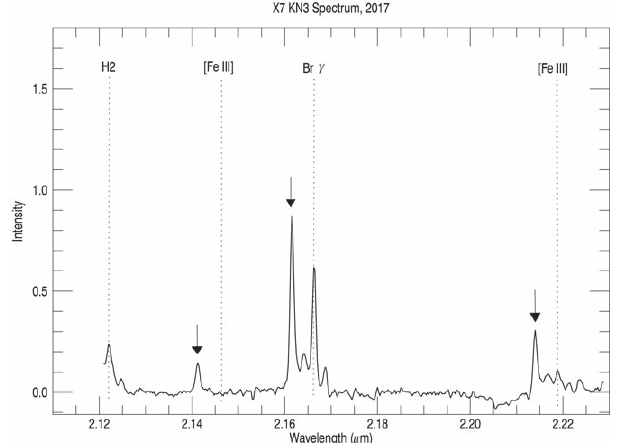
Figure 3. Spectrum of the X7 tip in 2017 with the Kn3 fi lter. The rest wavelengths of emission features of interest are highlighted with dotted lines, whereas the blueshifted emission associated with X7 is highlighted with